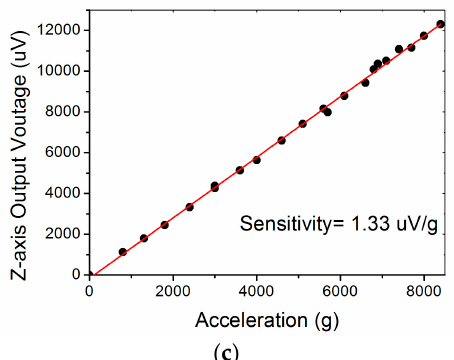
Figure 8. Testing results of the X-axis sensor, Y-axis sensor, and the Z-axis sensor, respectively in ( a–c ), by using a B&K 9525C compressing-air shock generating system.